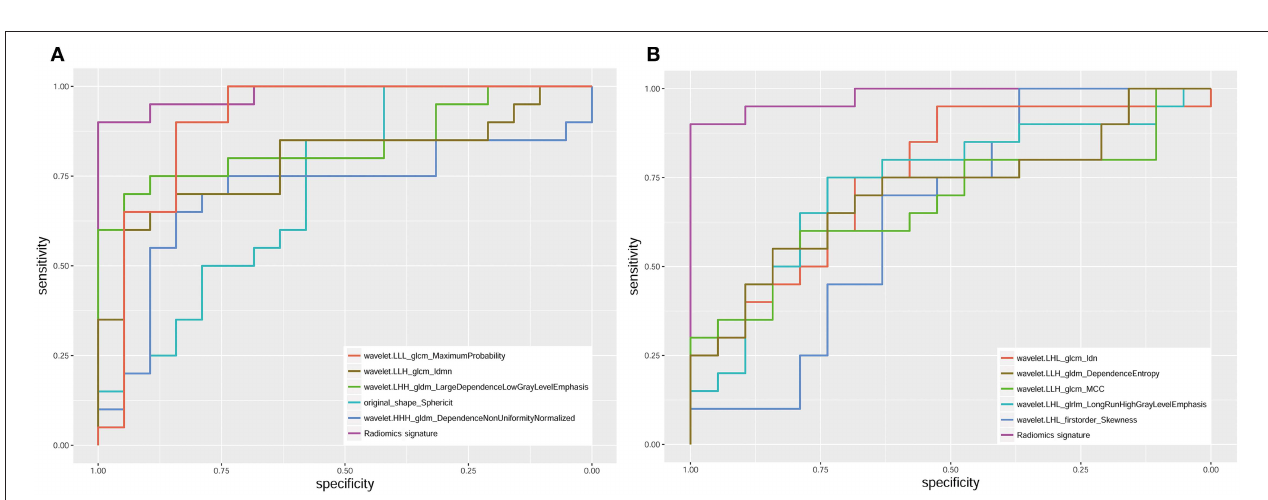
FIGURE 6 | ROC analysis of the radiomics signature and 10 features [ (A) the top 5; (B) the bottom five)] selected from mRMR. The AUC of the radiomics signature was 0.979 (95% CI: